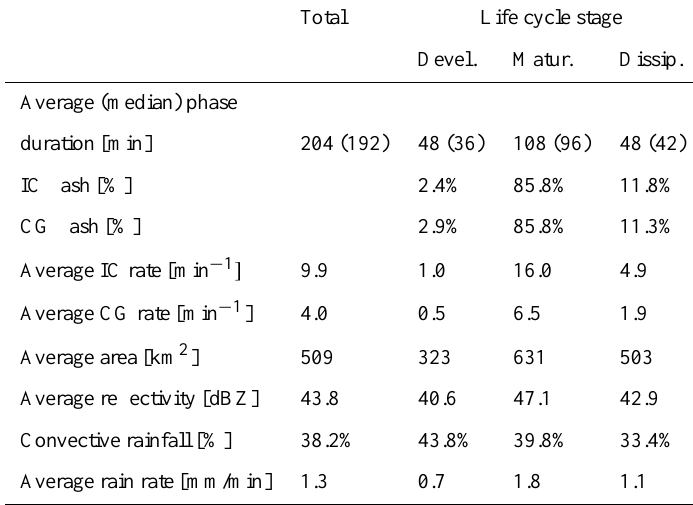
Table 1. Summary of thunderstorms, lightning and radar derived characteristics.